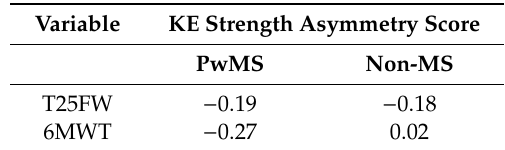
Table 6. Correlations coefficients between walking performance and knee extensor strength asymmetry scores.